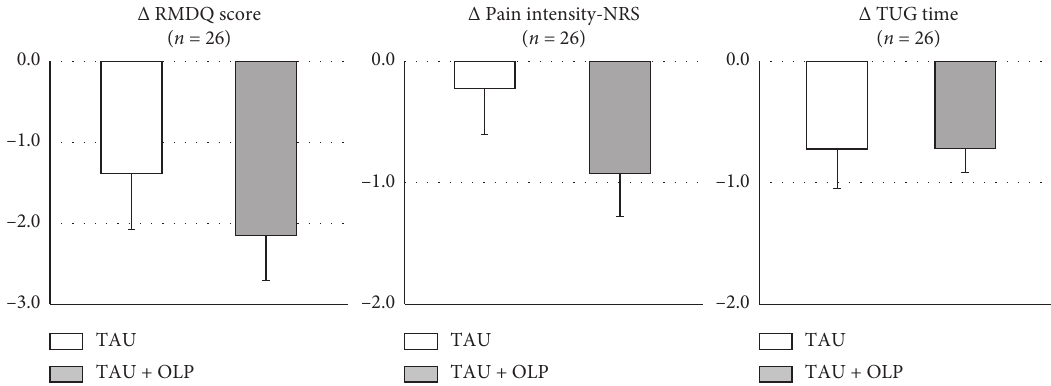
Figure 2: Changes in outcomes by the treatment group at week 3. Mean change scores on RMDQ score, pain-NRS, and TUG time. Error bars represent standard errors of the mean. RMDQ: Roland–Morris Disability Questionnaire; NRS: Numerical Rating Scale; TUG: Timed-Up-and-Go. Table 2: Changes in outcomes at week 3 and week 12 Changes from baseline ( n � 26) Changes from baseline ( n � 24) Week 3 Week 12